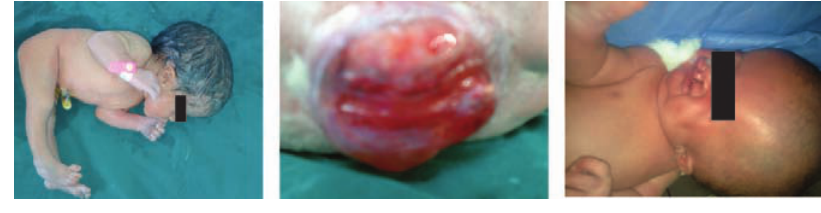
Figure 2. Congenital hydrocephalus and dorsolumbar meningeomyelocele; bilateral cleft lip and palate.